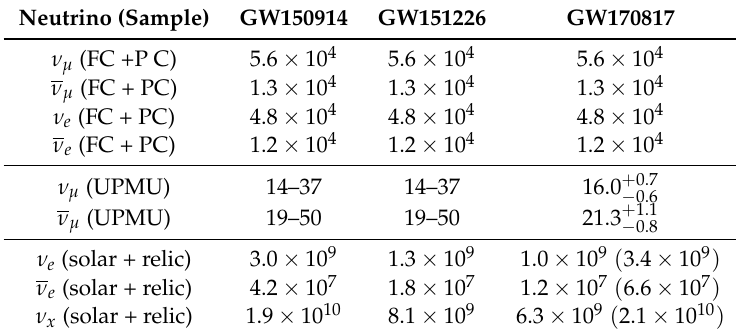
Table 4. Neutrino fluence limits at 90% C.L. from GW150914, GW151226, and GW170817. The unit for the neutrino fluence is cm − 2 . For GW170817 (NS-NS merger), two energy spectrum of neutrino emission is used; one is the flat spectrum with an index of zero, and the other is the Fermi–Dirac distribution with an average energy of 20 MeV. The latter is described in round